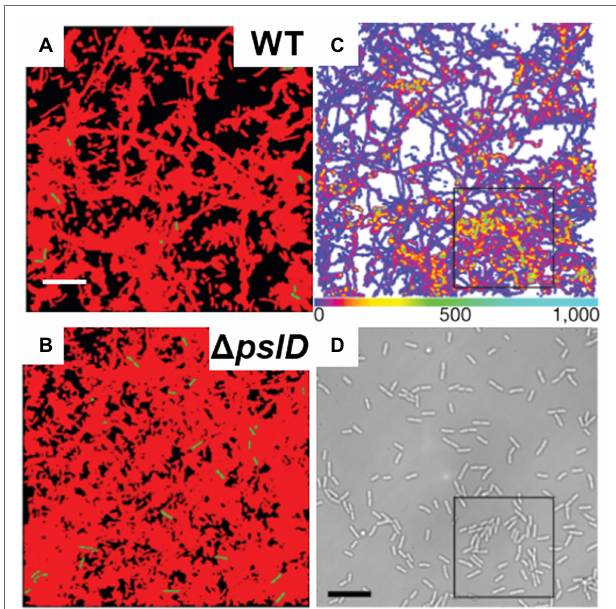
FIGURE 8 | P. aeruginosa adhesion controls surface motility and colonization. (A) and (B) illustrate the efficiency of surface coverage by bacterial trajectories with Psl trails. Shown are cumulative surface coverage images at 5 h for WT (A) and Δ pslD (B) , respectively. Red corresponds to areas visited by P. aeruginosa , and black corresponds to the unvisited areas. (C) Visit frequency map of WT cells for the first 15.7 h after inoculation, when microcolonies are just starting to form. The black square indicates an example of colony formation. (D) The brightfield image corresponding to (C) . Scale bars, 10 μ m. This figure is reproduced with permission from Zhao et al.